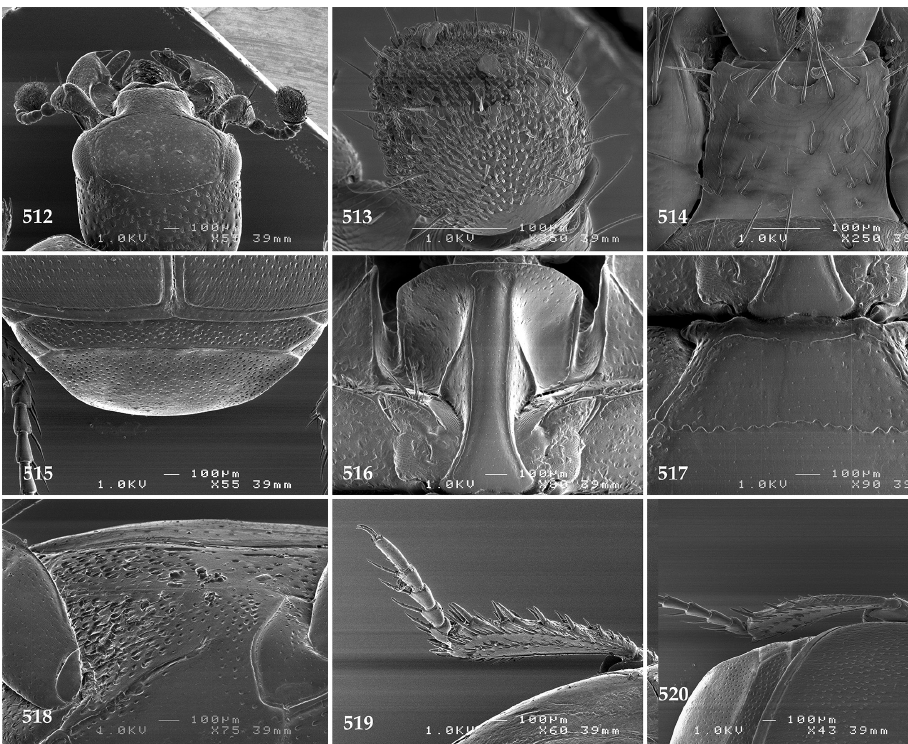
Figures 512–520. 512 Saprinus ( Saprinus ) pseudodetritus sp. n. head, dorsal view 513 antennal